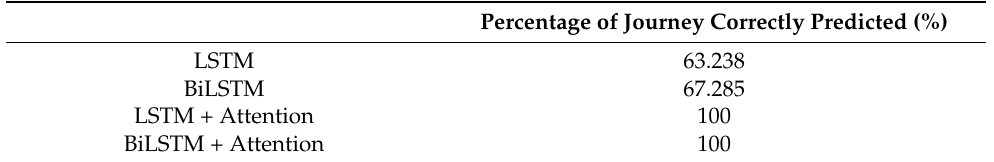
Table 9. Percent of journey correct for all models tested against the seen journey to Destination